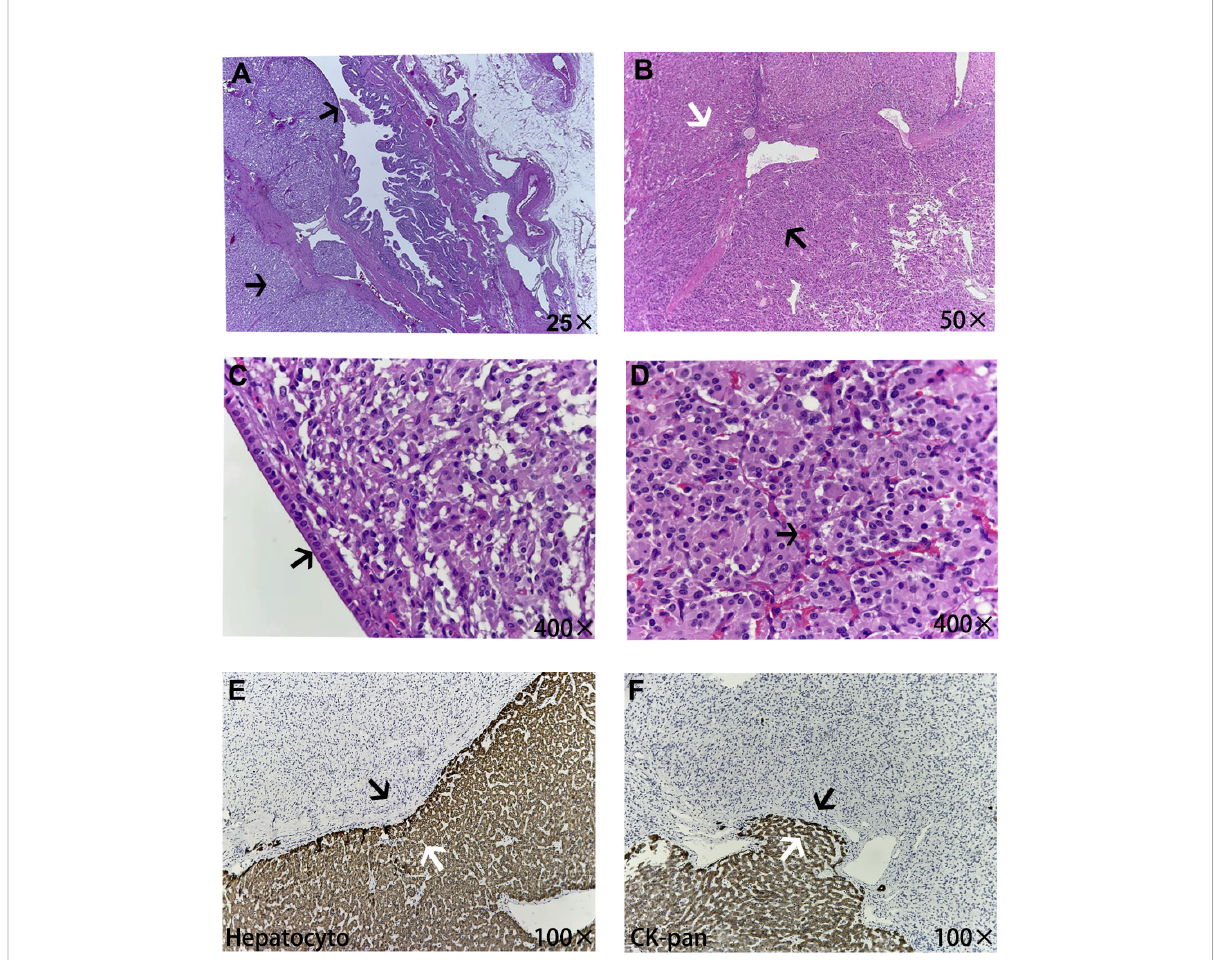
FIGURE 3 The microscopic pathological structure of tumor tissue. (A) The tumor was mainly located in the submucosa of the gallbladder (black arrow). (B) The white arrow shows normal liver tissue and the black arrow shows paragangliomas of the gallbladder tissue, in which tumor cells were diffusely distributed in clusters. (C) The gallbladder wall, which is surrounded by tumor cells, was covered with simple columnar epithelium structures (black arrow). (D) The paraganglioma demonstrated a characteristic zellballen architecture, rich in pink sinusoids inside (black arrow). Parts E and F show the junction structure of the tumor with adjacent liver tissues, and normal liver tissues all expressed the epithelial-derived markers Hepatocyto and CK-pan (white arrows), while non-epithelial paraganglioma tissue was negative (black arrows), which also indicated some degree of tumor invasion of the liver